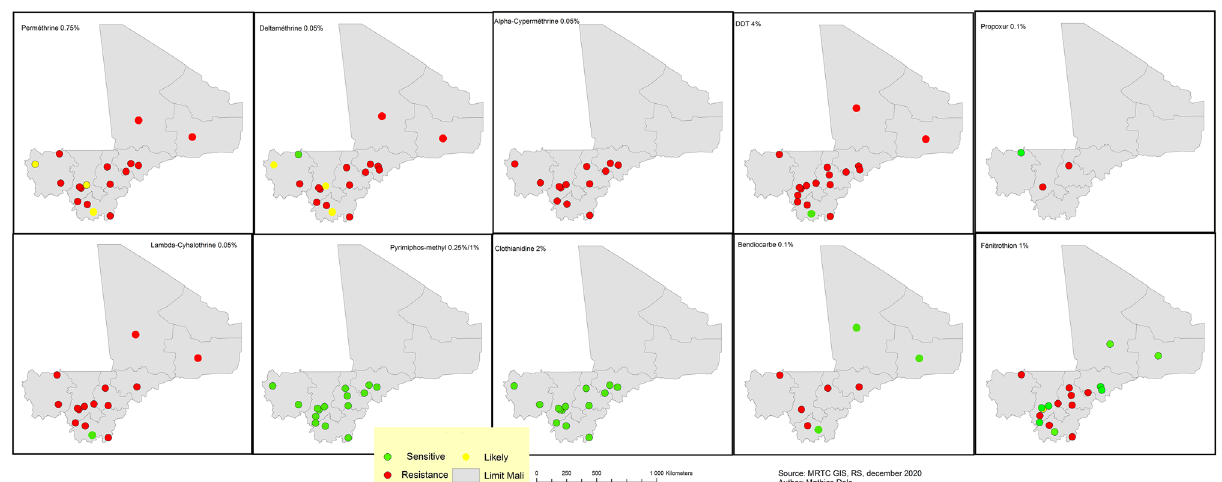
Figure 11. Map of distribution of vector resistance in sentinel sites, Mali, 2010–2019. Red dots represent vector resistance; yellow dots show moderate sensitivity (below 90%); and green dots show high sensitivity (above 90%). ArcGIS Desktop version 10.8 software (Environmental Systems Research Institute (ESRI), 380 New York Street, Redlands, CA 92373-8100, USA, https:// www. esri.